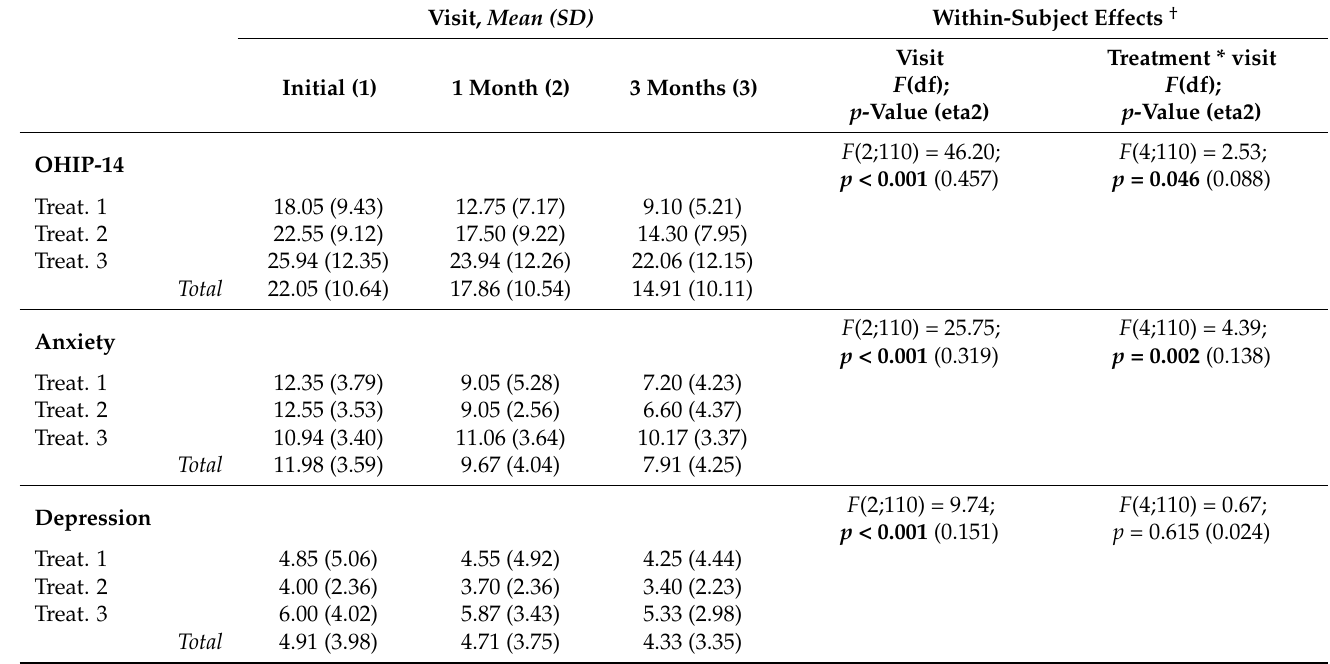
Table 4. Mean values (standard deviation SD) and statistical contrasts between treatments of the OHIP-14; anxiety and depression.